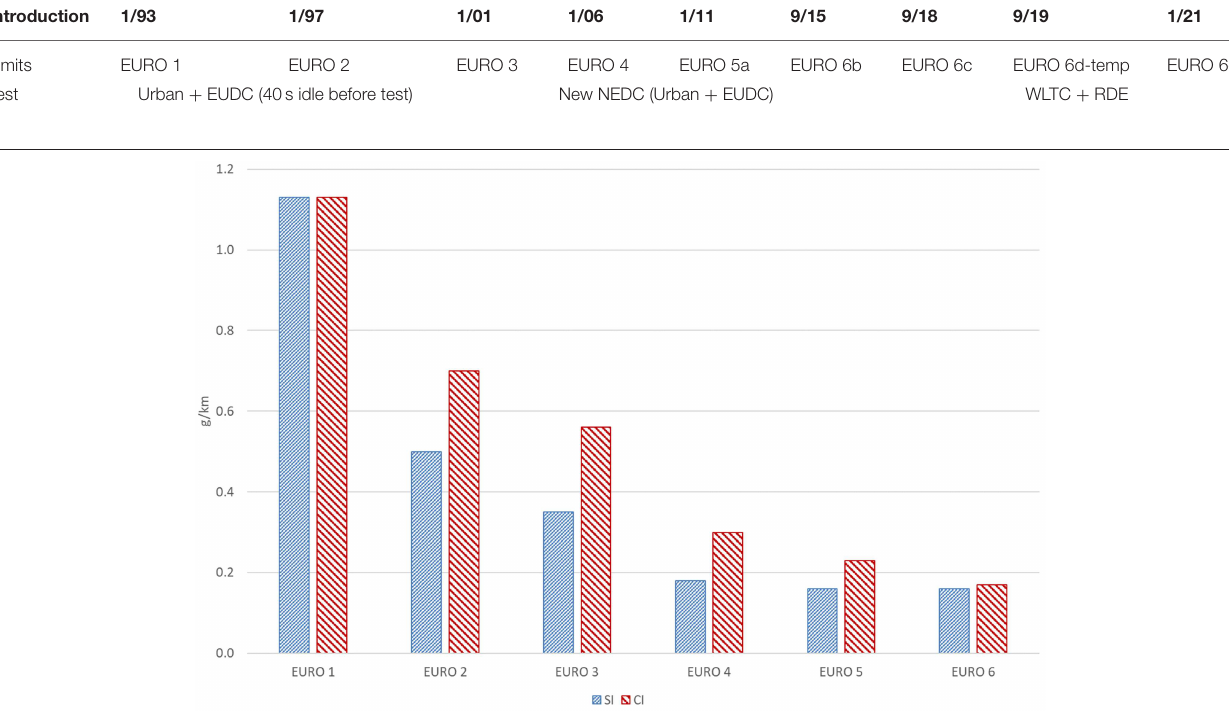
FIGURE 1 | Limits for HC + NO x for passenger cars in Europe (DELPHI Technologies,